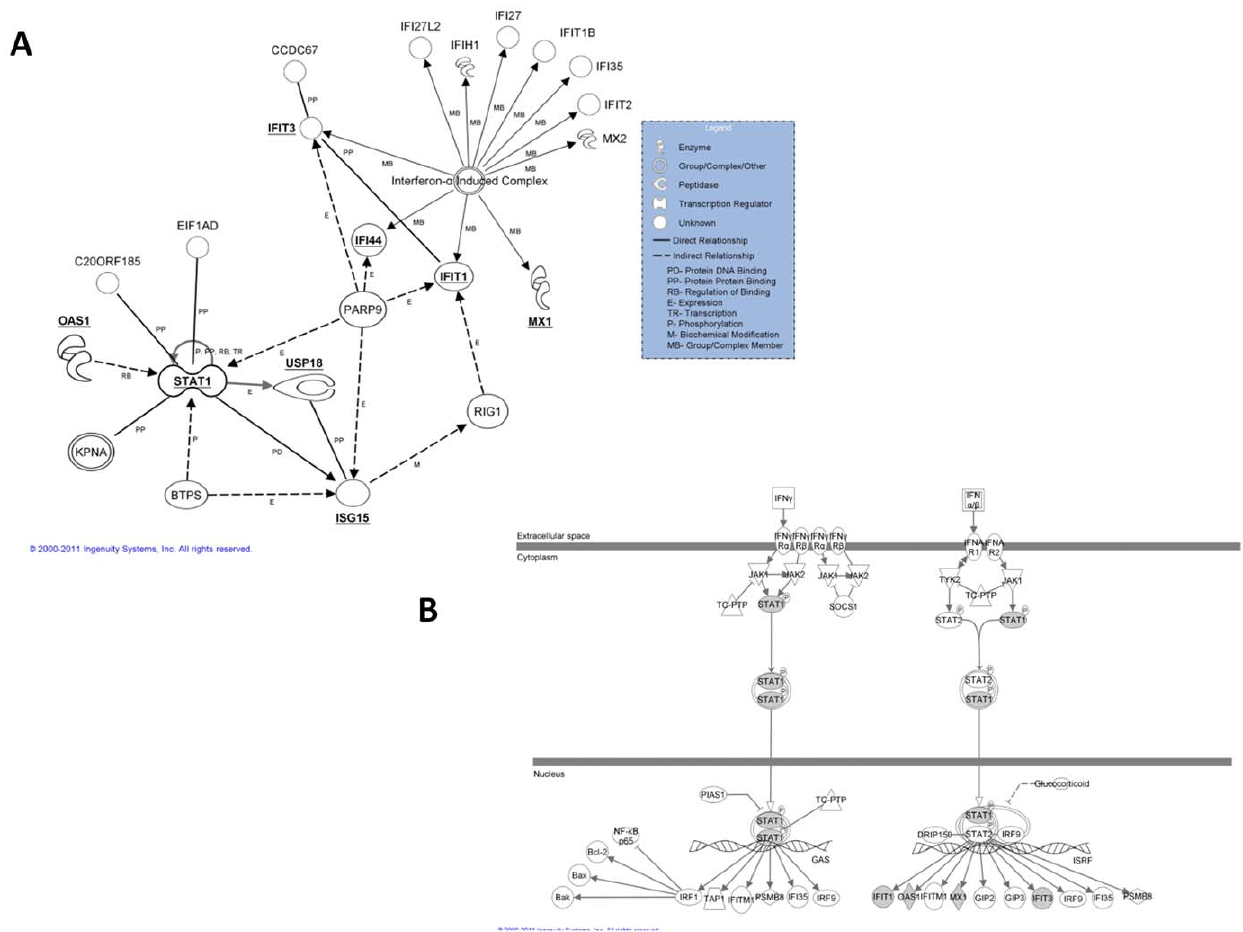
Figure 4. Functional Annotation networks from IPA (Ingenuity Pathway Analysis) that show documented gene relationships among the genes in the hypothesized eight gene STAT1/IFN gene set (A) and that show the functional relationships among these genes as they relate to Interferon signaling (B) (genes in eight gene signature are shaded).